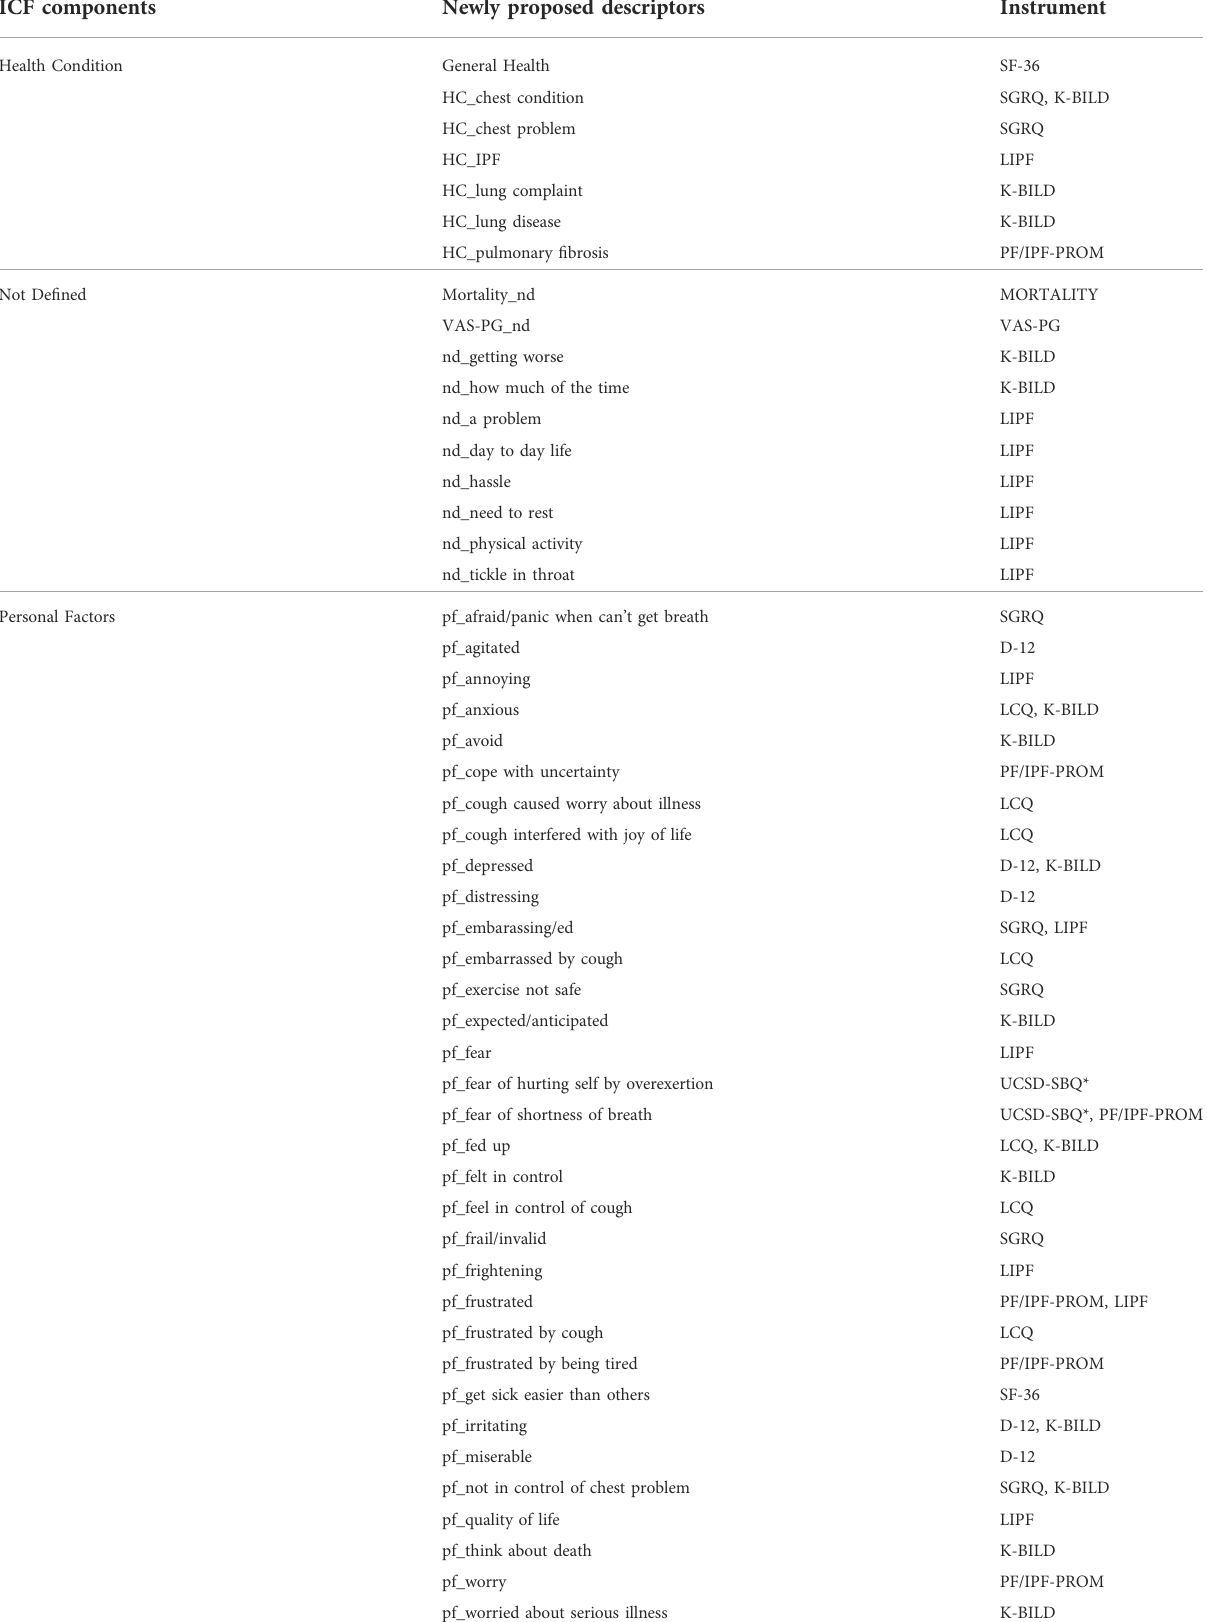
TABLE 6 Additional considerations for ICF ILD linkages from instruments and domains ( Courtesy LA Saketkoo, with permission, rights reserved